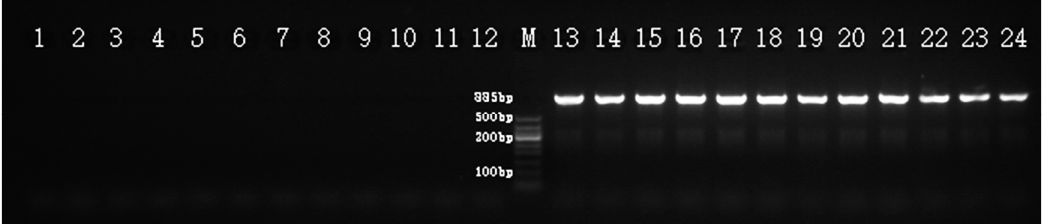
Figure 4. Amplification profile of the SCAR marker Hrcx-15 in H. rhamnoides , showing the 885 bp fragment, indicated with an arrow, in all female samples. Lanes 1–12: male, lanes 13–24: female. M, DNA Marker DL500 (Takara, Dalian, China).